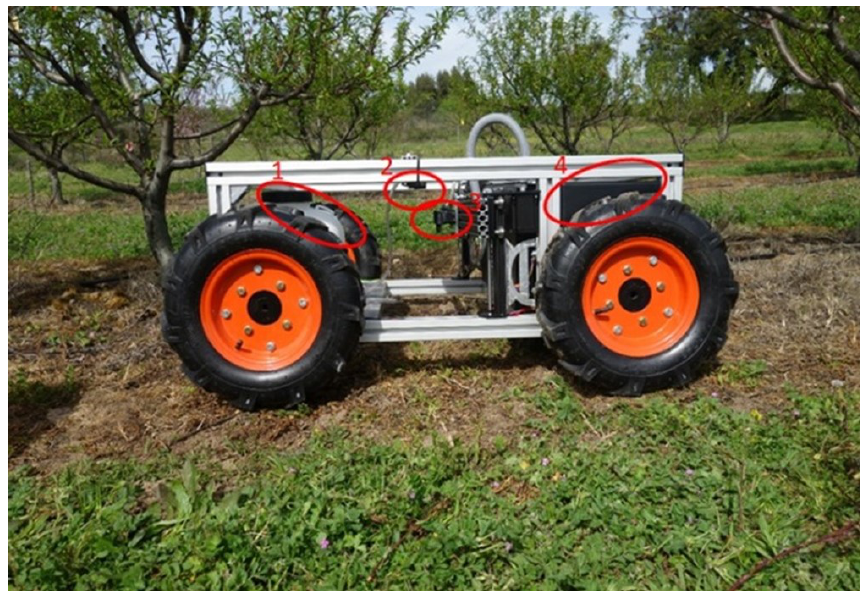
Figure 5. Robotic Rover for agricultural applications: (1) herbicide reservoir; (2) camera; (3) Cartesian robotic manipulator with spray nozzle; (4) control